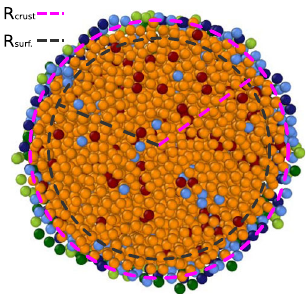
Fig. 5 Crust and surface radiuses in an Au 6266 NP. Depiction of the values of R crust (pink) and R surf. (grey) for an Au 6266 NP. Atoms are colour-coded according to their class as yielded by the clustering algorithm, and mirror the ones of Figs. 1